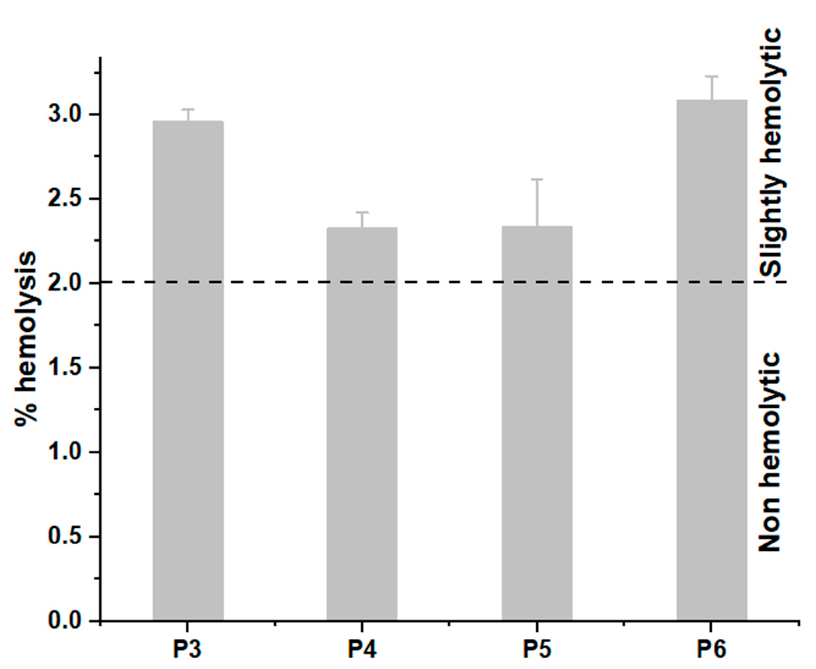
Figure 12. Hemolysis of the silver-based samples (P3, P4, P5, and P6) against hRBCs after 4 h of treatment at 102.2 µM.